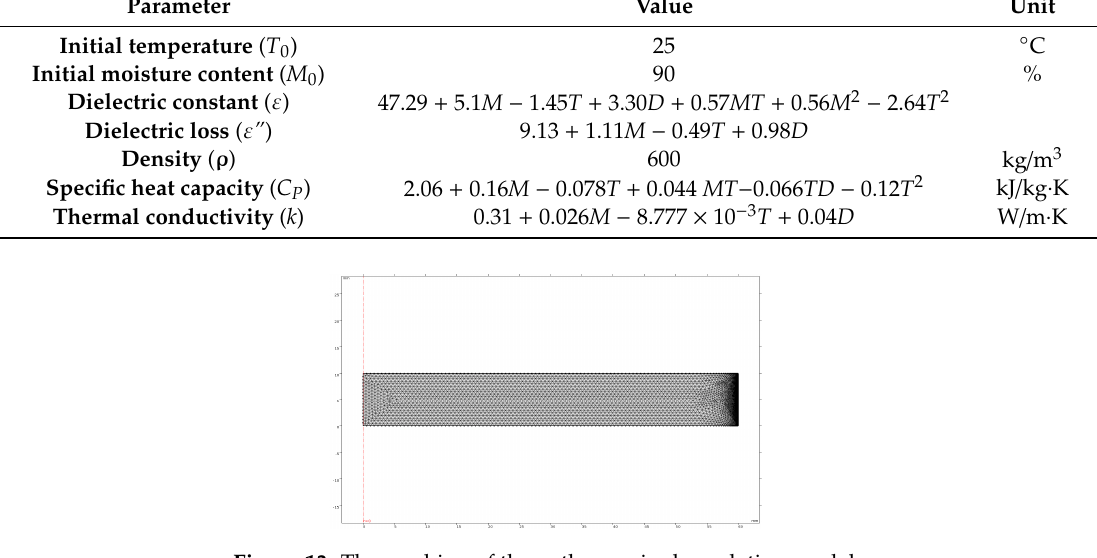
Figure 13. The meshing of the anthocyanin degradation model.